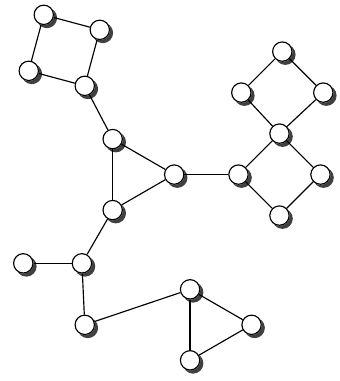
Figure 17. Cycles connected by bridges or articulation Figure 16: Cycles connected by bridges or articulation points.